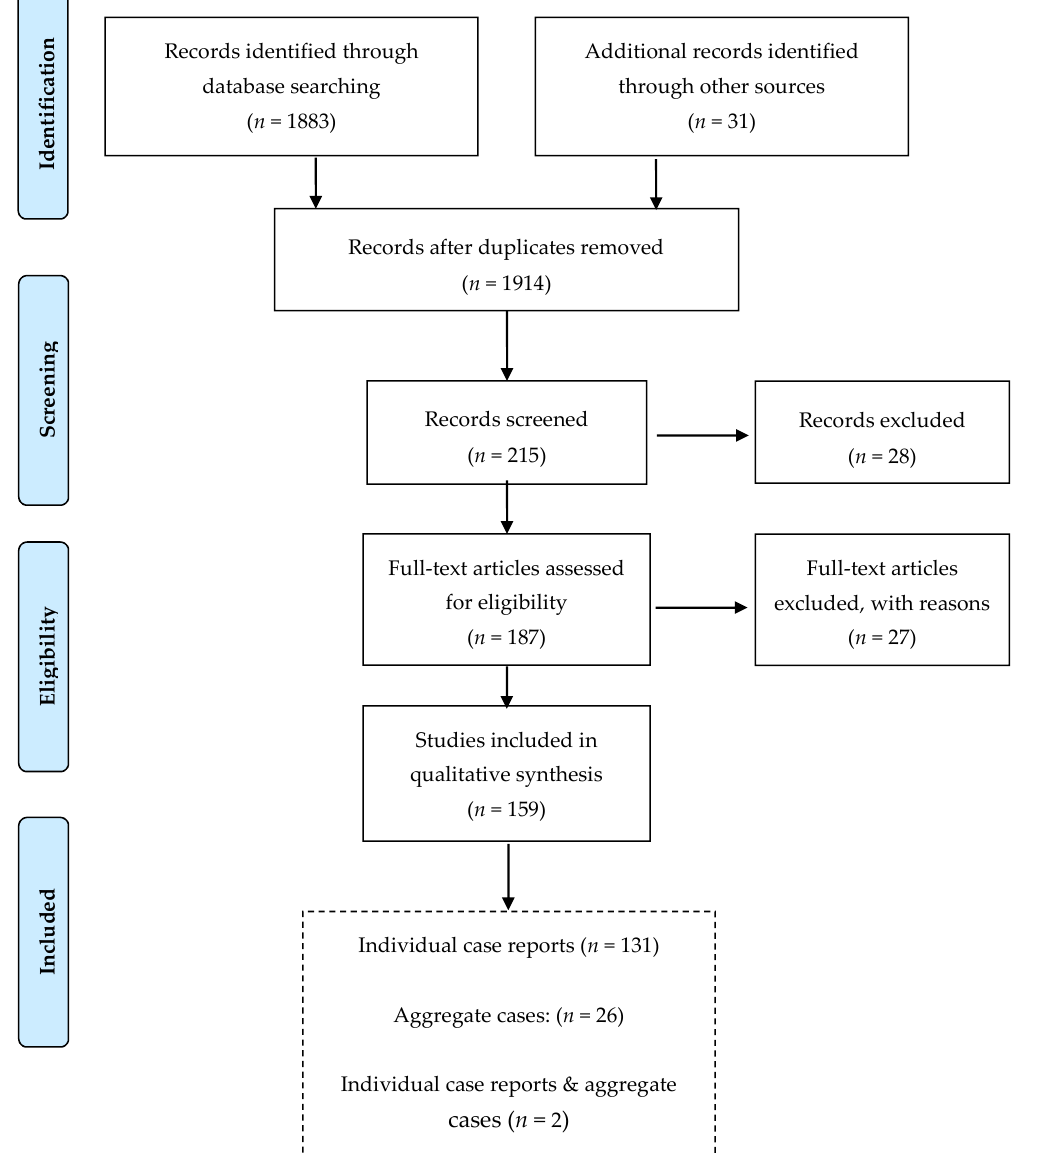
Figure 1. Flow chart of the process to identify and screen published case reports of e-cigarette-related illness and injury.